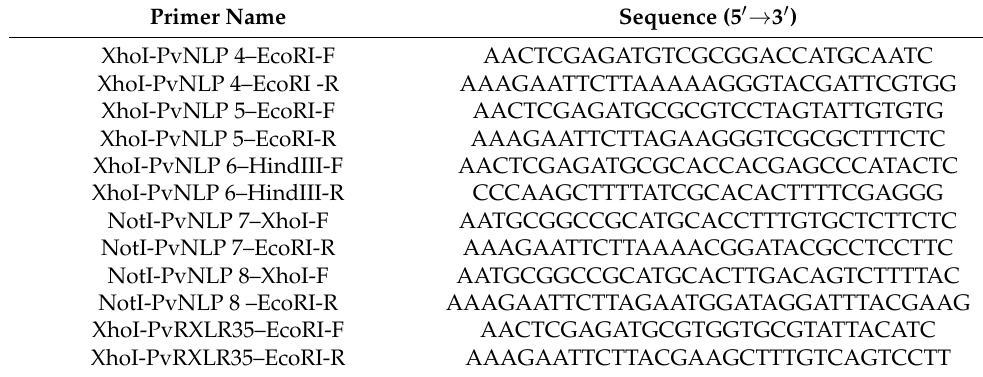
Table 3. Oligonucleotides used for cloning binary vectors for transient expression in N. benthamiana